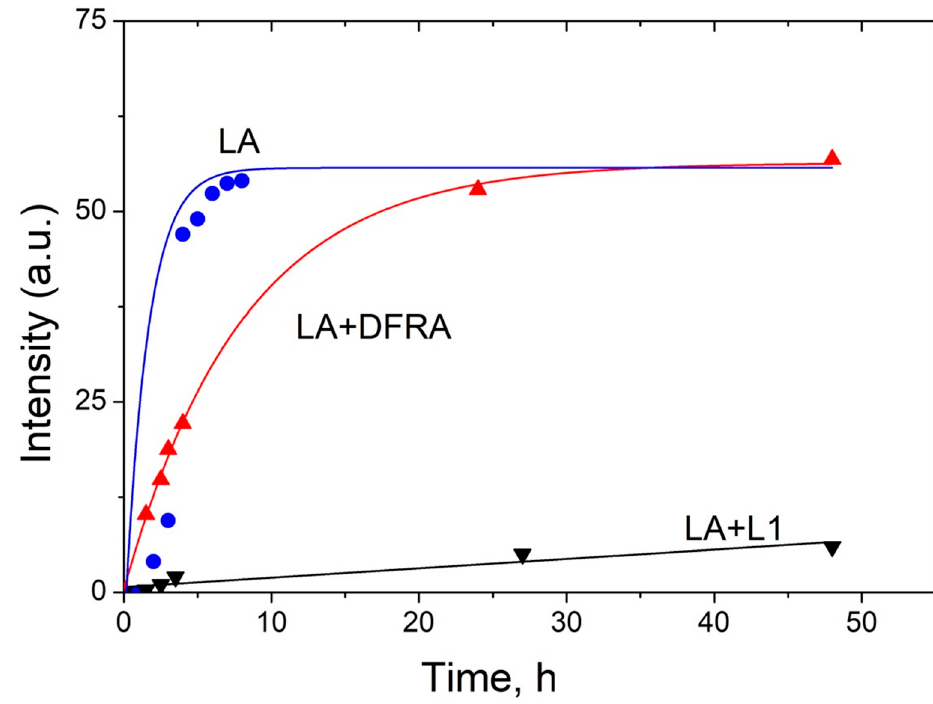
Figure 6. Kinetics of the termination reaction step of the linoleic acid (LA, 3.5 mM) peroxidation leading to polymeric products formation, which are induced by FeSO 4 (0.1 mM) and H 2 O 2 (0.5 M) in the absence and in the presence of deferasirox (DFRA, 2 mM) and deferiprone (L1, 2 mM). The studies were carried out at room temperature, in buffer solution (0.1 M) of pH 7.4. The graphs have been plotted using the decay of the integral intensity signal of the LA protons at 0.9 ppm (a.u., arbitrary units).